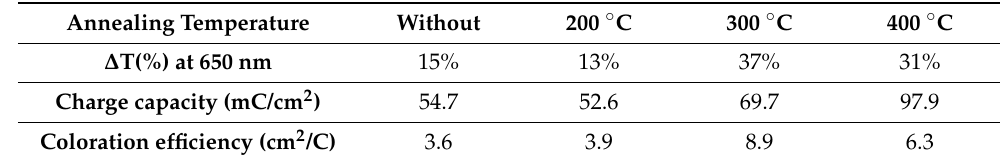
Figure 5. The transmittance of the thermal annealed V 2 O 5 thin film, the original sample (square), oxidation state (circle), and reduction state (triangle), after annealing at ( a ) 200, ( b ) 300, and ( c ) 400 °C, respectively. Table 1. Summary of the transmittance difference, charge capacity, and coloration efficiency of the V 2 O 5 thin film after various temperature annealing.